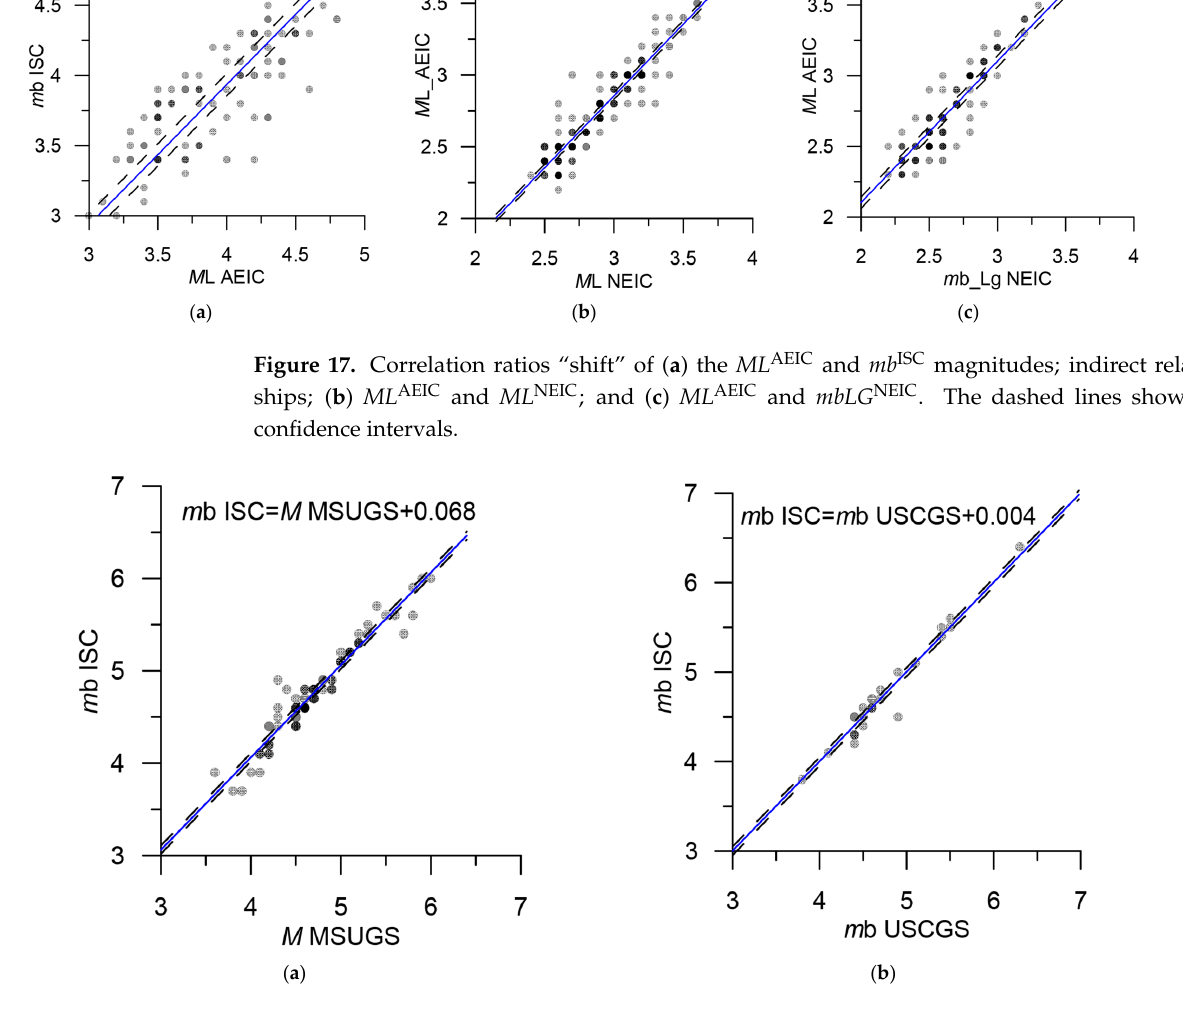
Figure 18. Correlation ratios of the magnitudes MSUGS, USCGS, and mb ISC . ( a ). M MSUGS . ( b ) mb USCGS . The dashed lines show 95% confidence intervals.